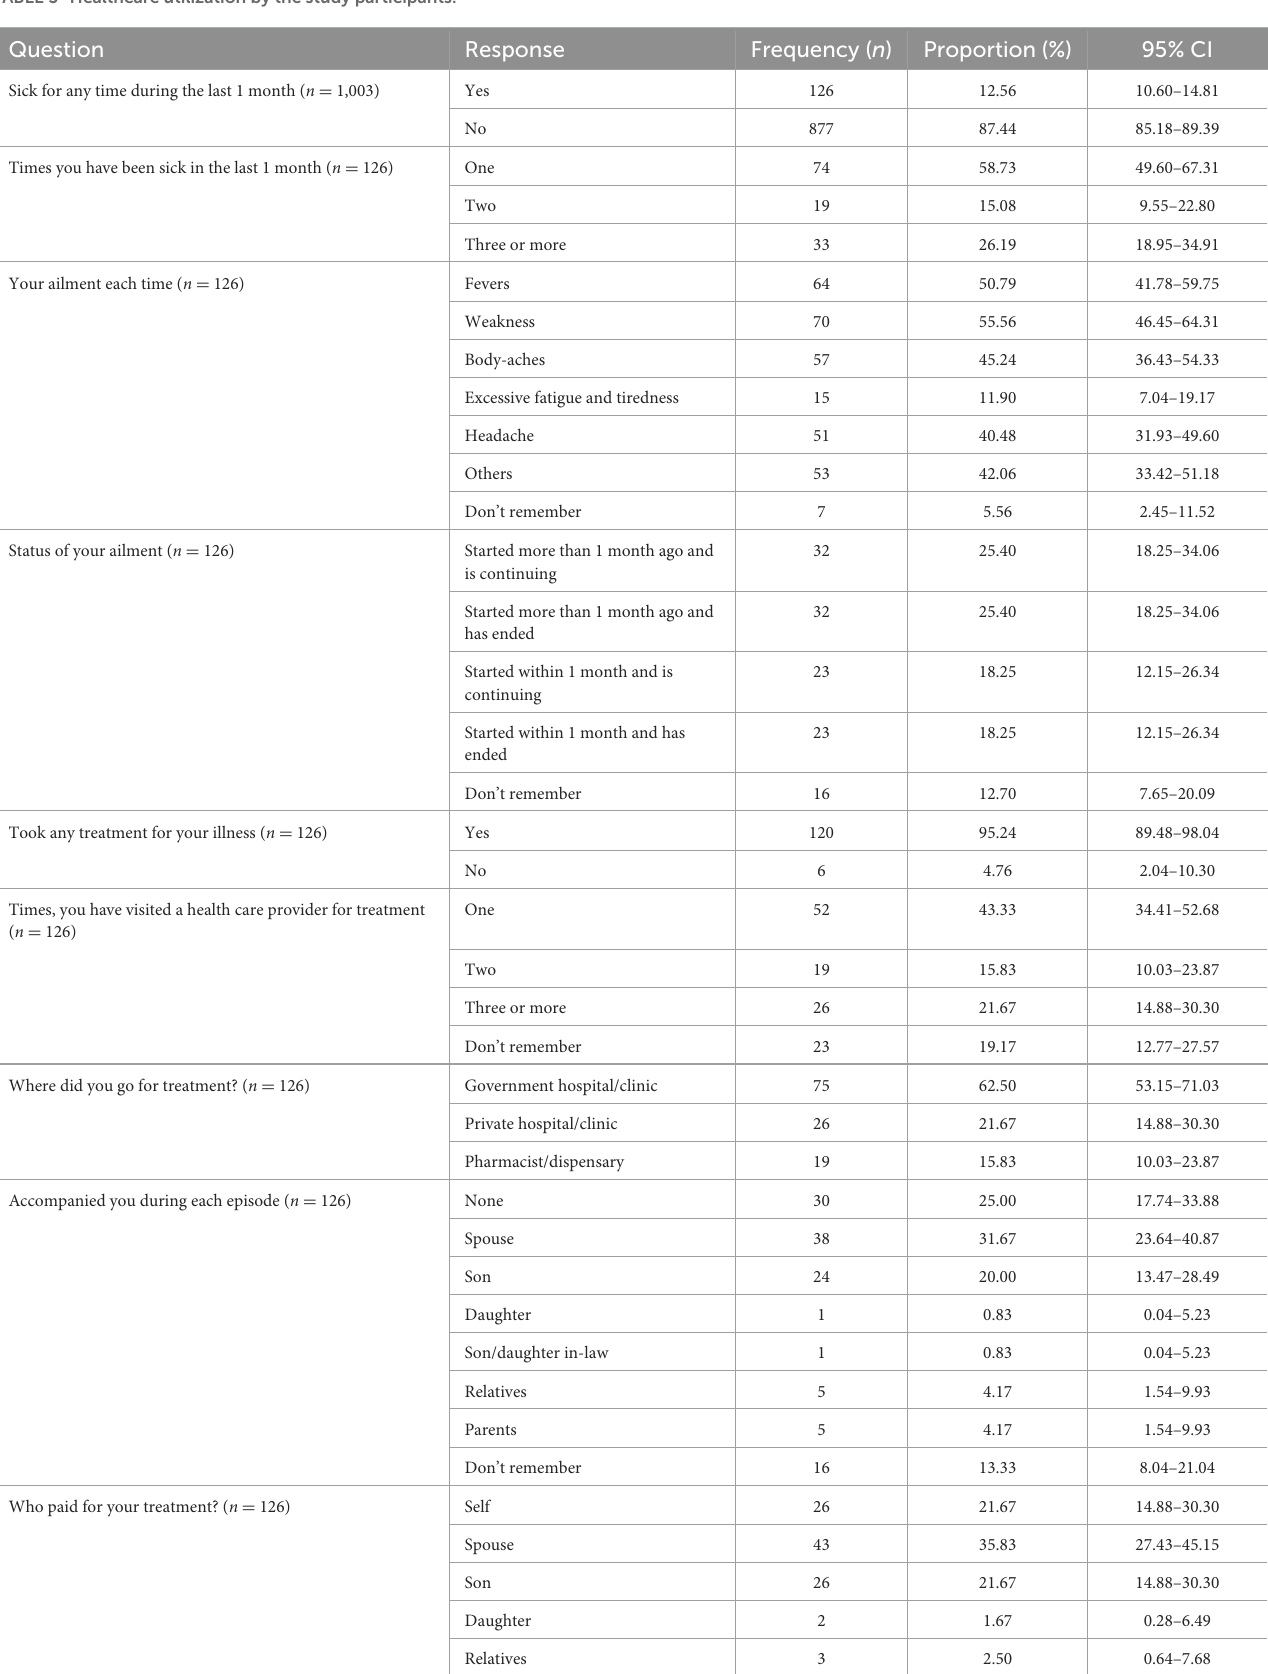
TABLE 3 Healthcare utilization by the study